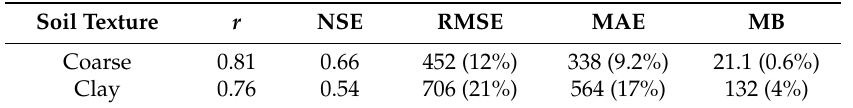
Table 3. Evaluation of the goodness-of-fit between the model simulations and the observations in the validation datasets † .